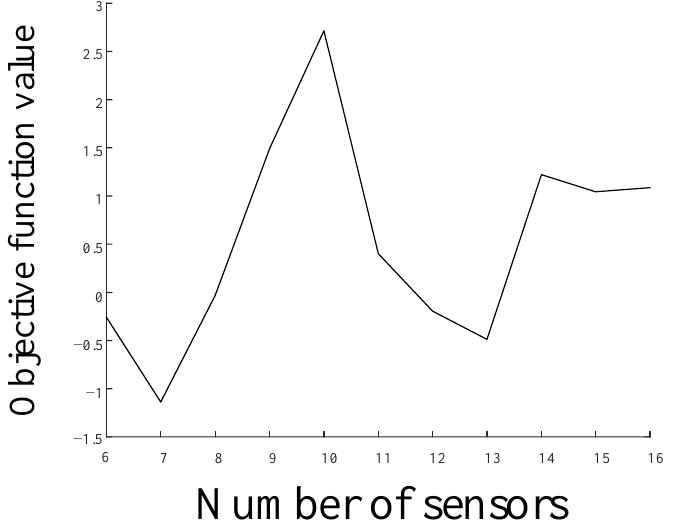
Figure 12. Objective function value for Industrial robot without the simulation model.